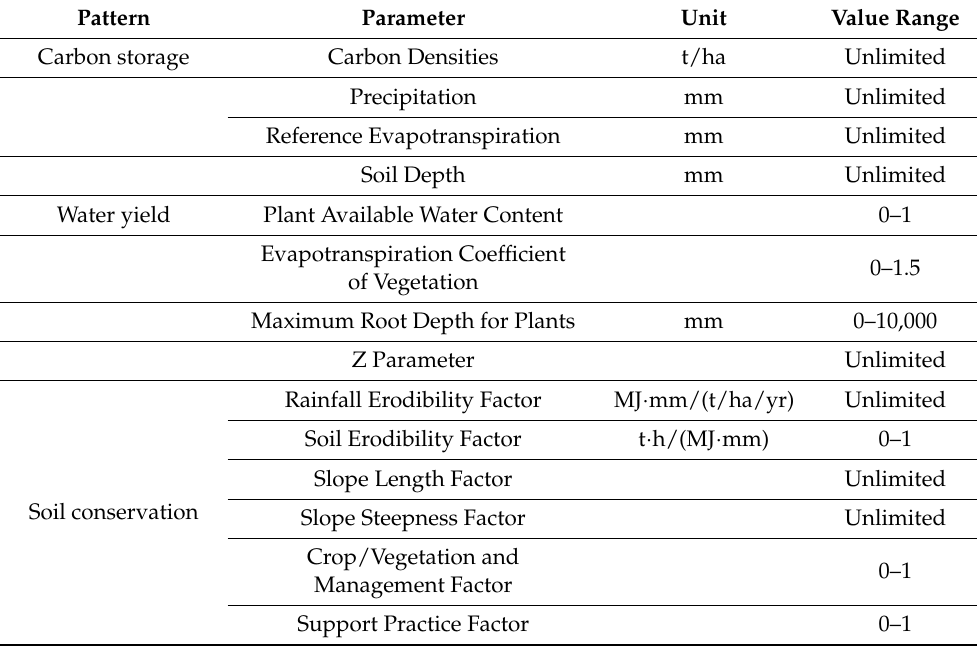
Table 1. Evaluation parameters and value range of